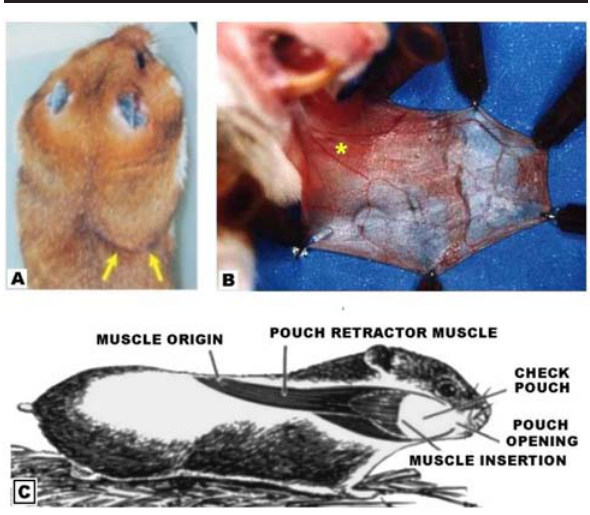
FIGURE 1 - Syrian golden hamster ( Mesocricetus auratus ).